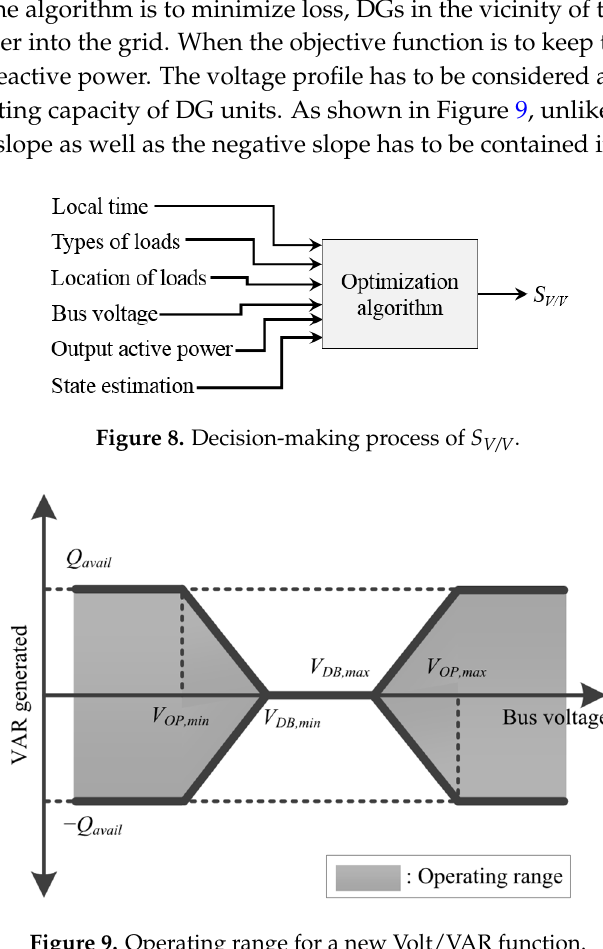
Figure 9. Operating range for a new Volt/VAR function.